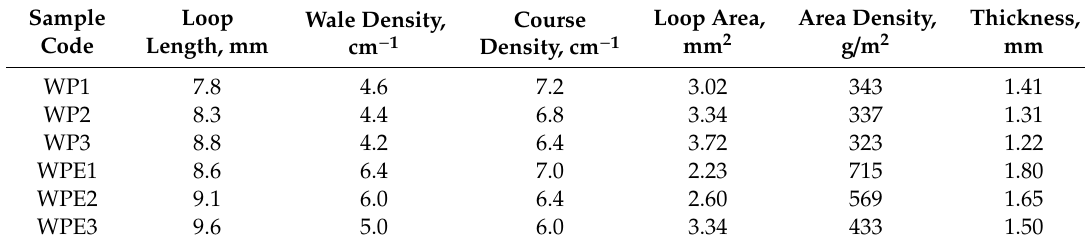
Figure 1. Images of knitted structure (technical face and technical backsides): ( a ) weft plain (WP); ( b ) weft fleece pattern (WPE); ( c ) knitting diagram of WP; and ( d ) knitting diagram of WPE. Table 1. Structural parameters of knitted fabrics.